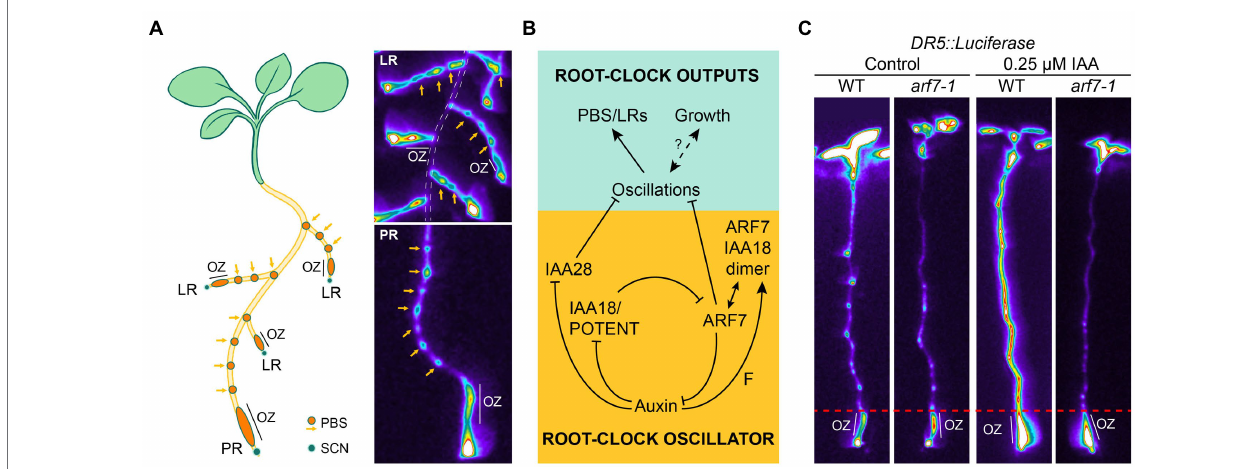
FIGURE 1 | The activity of the Root Clock results from an inner oscillator. (A) Left: Schematic representation of the location of Oscillation Zone (OZ) and PreBranch Sites (PBS) in the root system. Right: Location of the OZ and PBS visualized by DR5::Luciferase expression in the primary (PR) and lateral roots (LR). Note that the LR (top right image) show OZ and form PBS the same as the PR (bottom right image). The PR is delimited by a dasshed white line in the top right image. SCN: Stem Cell Niche. (B) Model of the core genetic circuit driving the Root Clock as adapted from (Perianez-Rodriguez et al., 2021). ARF: Auxin Response Factor. IAA: Aux/IAA protein inhibitors. F: predicted factor promoting dimer formation. (C) DR5::Luciferase expression in 6 days post imbibition (dpi) plants treated with 0.25 μ m auxin (indol-3-acetic acid, IAA) for 1.5 h. Note that activation of DR5::Luciferase occurs in the OZ of arf7-1, whereas it is impaired in the root region above as delimited by the dashed red line. This switch in behavior of DR5::Luciferase delimits the end of the Root Clock oscillations and marks the initiation of LR organogenesis through PBS activation (PBS activation is followed by LR initiation and